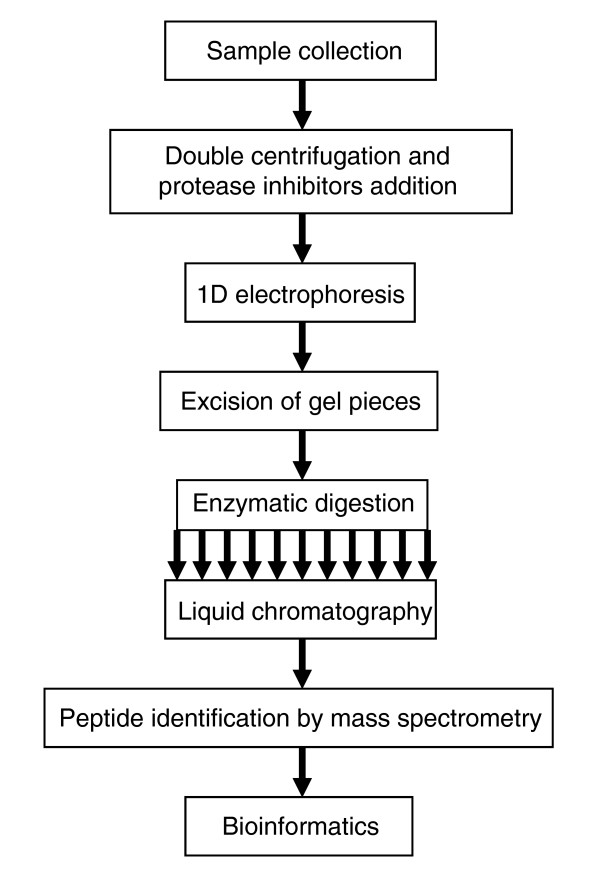
An overview of the procedure used for identification of the seminal plasma proteome.